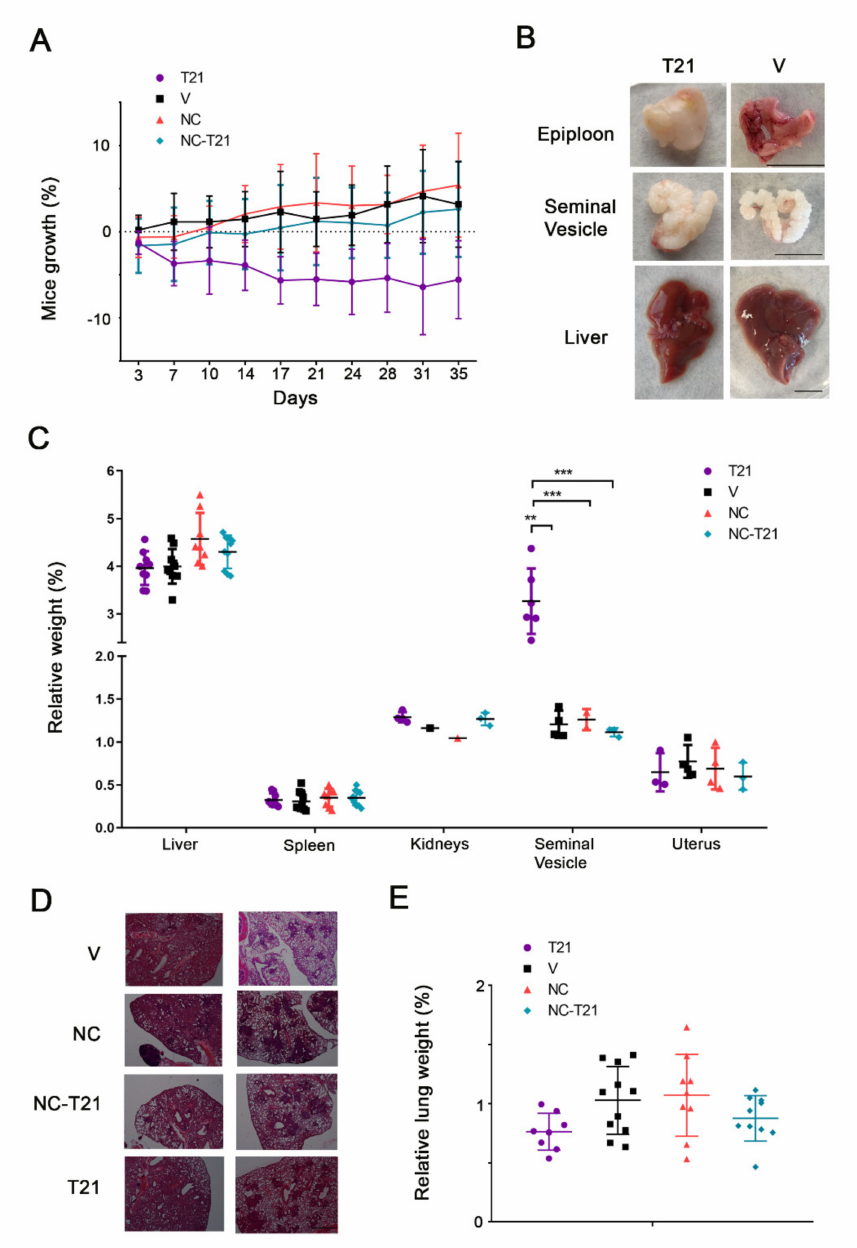
Figure 10. Analysis of the tolerability and therapeutic effect of NC-T21 treatment. Lung tumors were induced in mutant mice by virus inhalation, as described in Materials and Methods. 12 weeks after, mice were treated twice a week, with 6 mg/kg of nanoencapsulated T21 (NC-T21); with PBS (V), with empty nanocapsules without T21 (NC) or with free T21 (T21). ( A ) Mice weight was monitored during treatment. ( B ) Macroscopic differences in epiploon, seminal vesicle, and liver were observed in mice treated with T21. Scale bar 1 cm ( C ) Organs and ( E ) Lungs were weighed at final point and relativized to mice total weight. ( D ) Pictures of hematoxylin/eosin staining of lung tumors were taken. Scale bar 0.5 mm. ** p > 0.01, *** p >